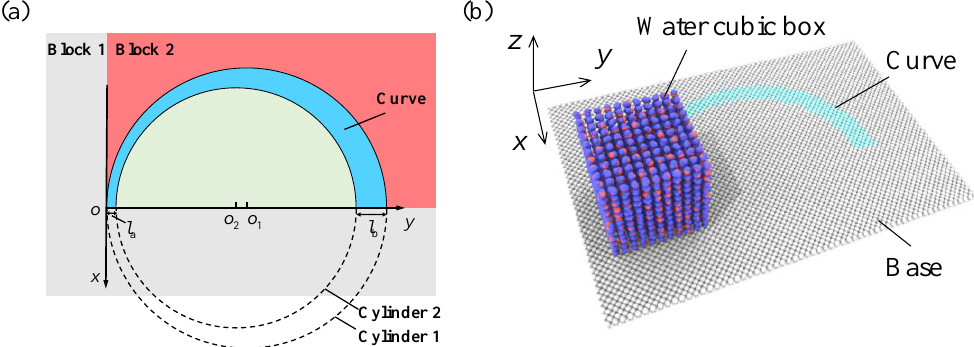
Figure 1. ( a ) Generation of the curve track. ( b ) Initial configuration of the simulation system.